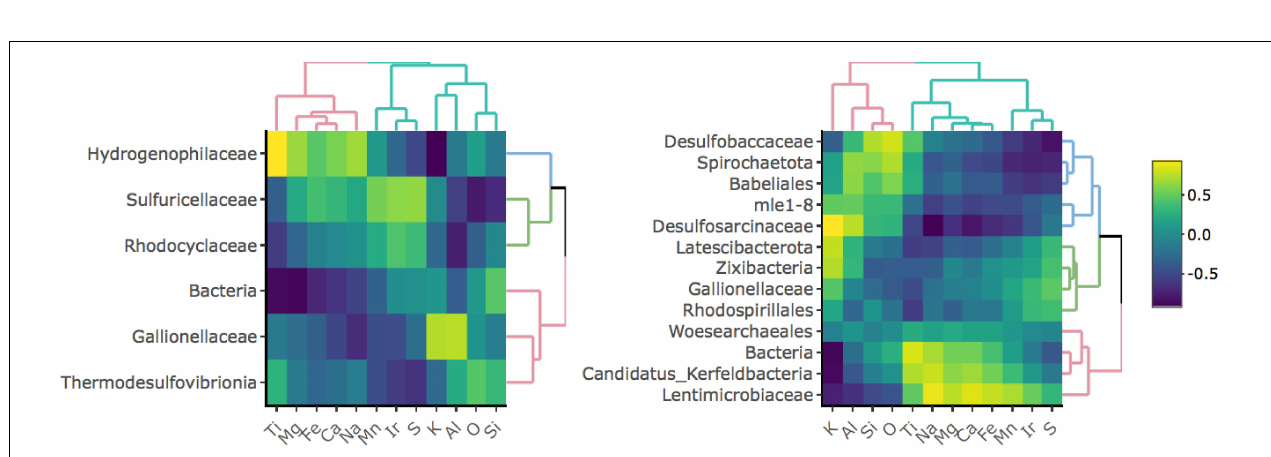
FIGURE 3 | Correlation matrices between taxa and bulk rock chemistry for D1 (left) and D3 (right) communities. Only taxa that comprise at least 1% of and are present in at least 50% of communities for a given site are shown.